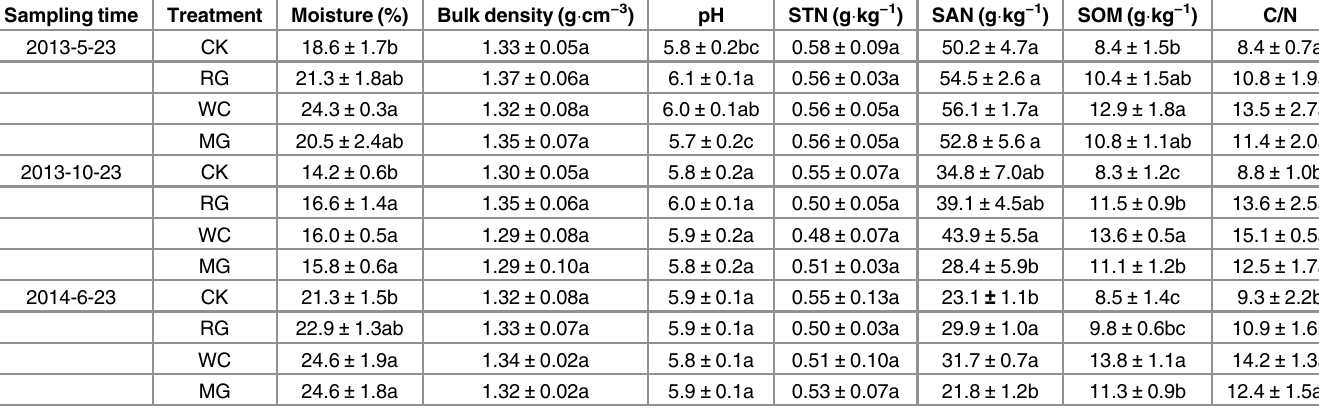
Table 1. Soil properties at the 0 – 5 cm depth at the three sampling time points with and without mulching treatments. Sampling time